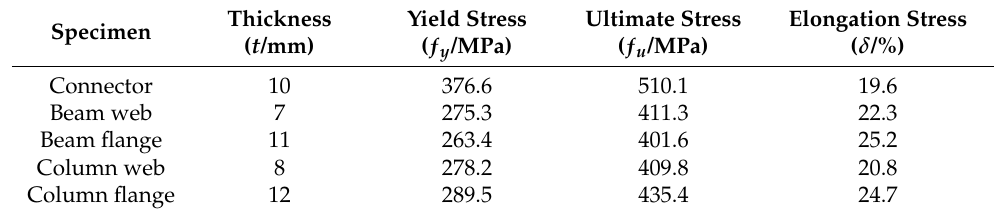
Figure 1. Details of the material properties test. ( a ) Tensile coupons; ( b ) ALC blocks; ( c ) universal hydraulic testing machine. Table 1. Material performance test results.